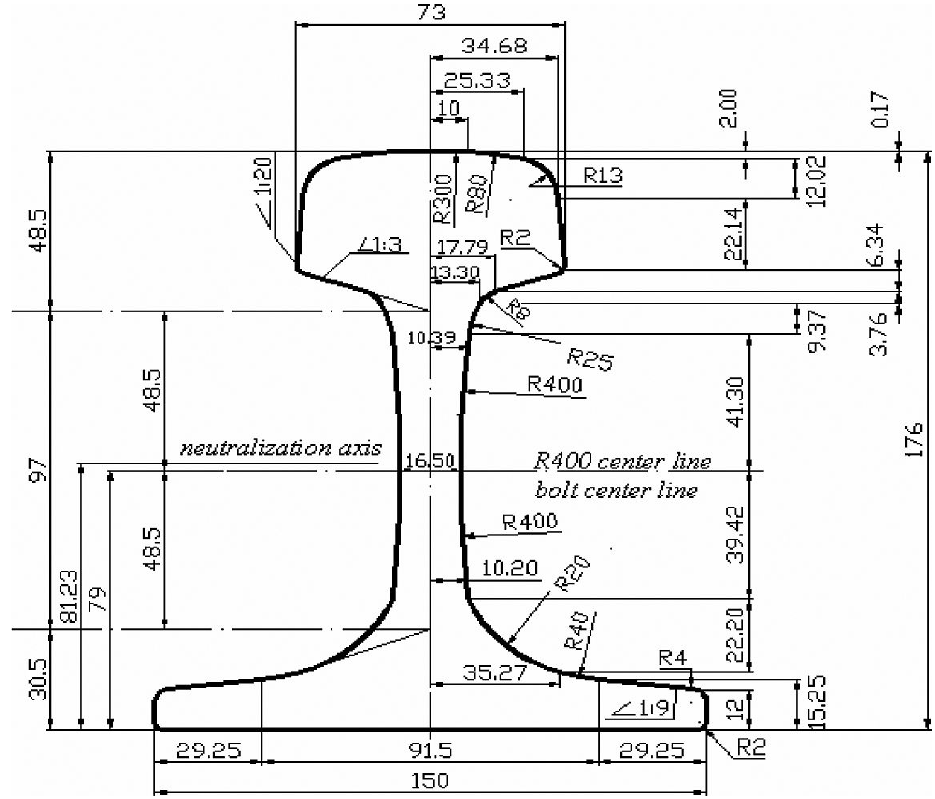
Fig. 1. Section size of 60 Kg/m heavy